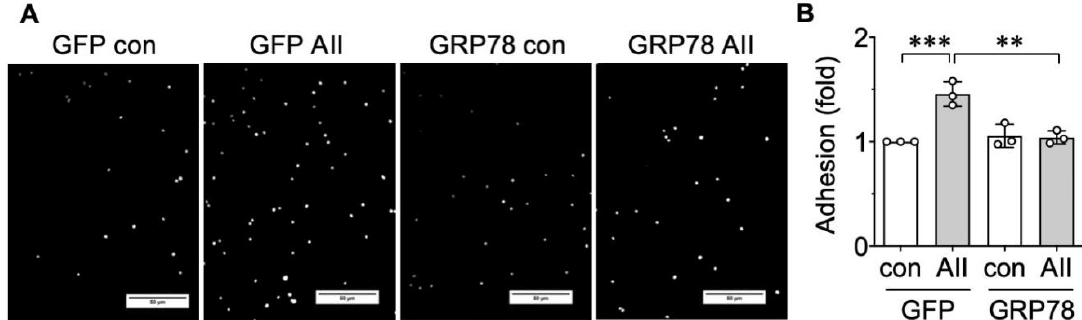
Figure 4. Upstream role of endoplasmic reticulum (ER) stress in VSMC inflammatory response induced by AngII. ( A and B ) The rat aortic VSMCs infected with adenovirus encoding GRP78 or control GFP (100 moi) for 48 h were stimulated with 100 nM AngII (AII) for 48 h. ( A ) Images of Hoechst labeled adherent THP-1 cells incubated on VSMC monolayer for 30 min. The scale bar indicates 50 µ m. ( B ) The bars in the graphs show the mean ± SD from 3 independent experiments. ** indicates p < 0.01. *** indicates p < 0.001.